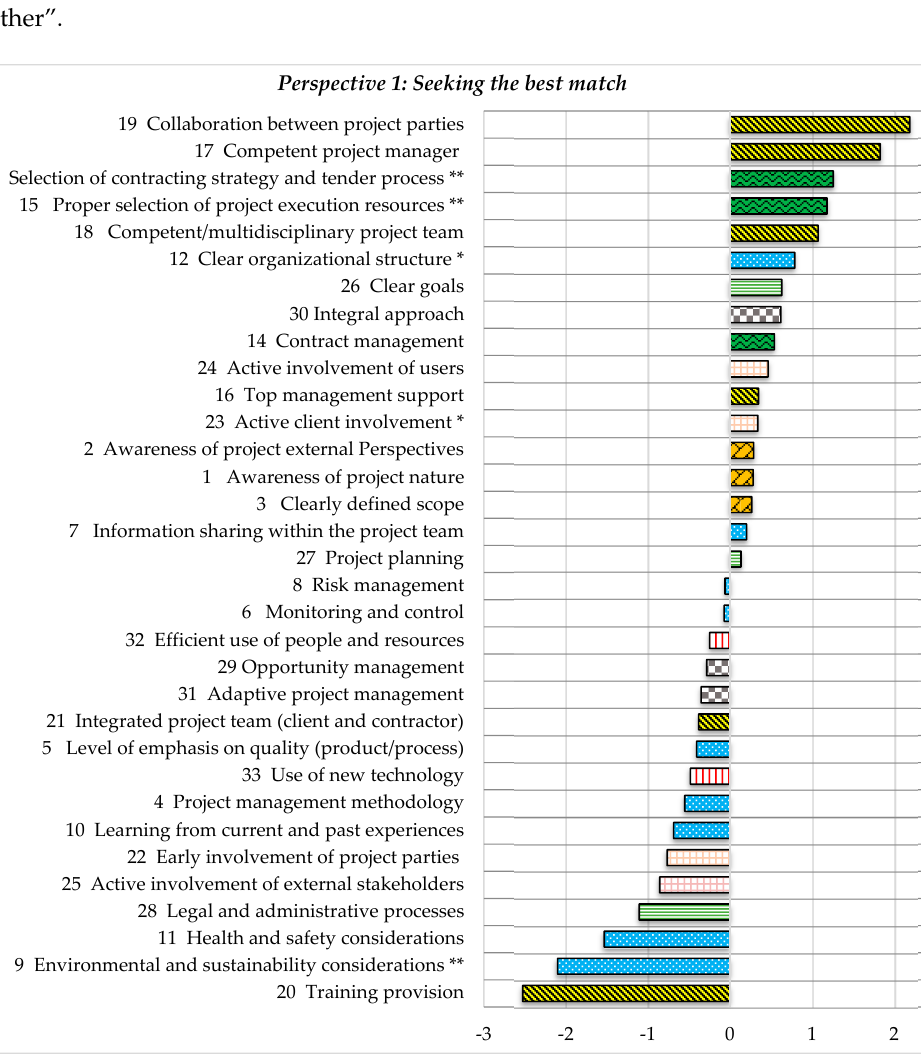
Figure 2. Ranking of success factors for seeking the best match perspective (P1). * The factor is distinguishing at p < 0.05; ** The factor is distinguishing at p < 0.01.